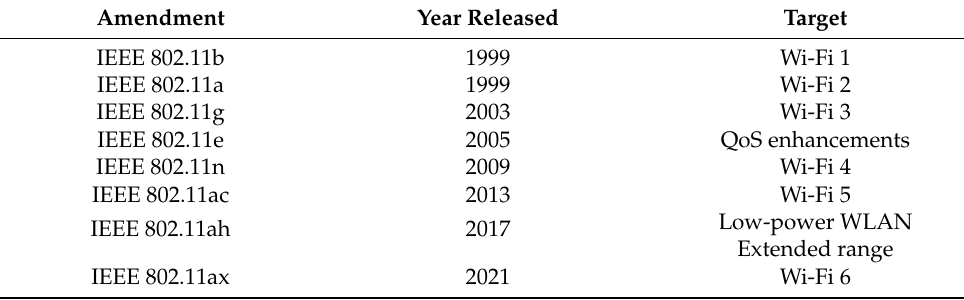
Table 1. Wi-Fi amendments relevant to Wi-Fi